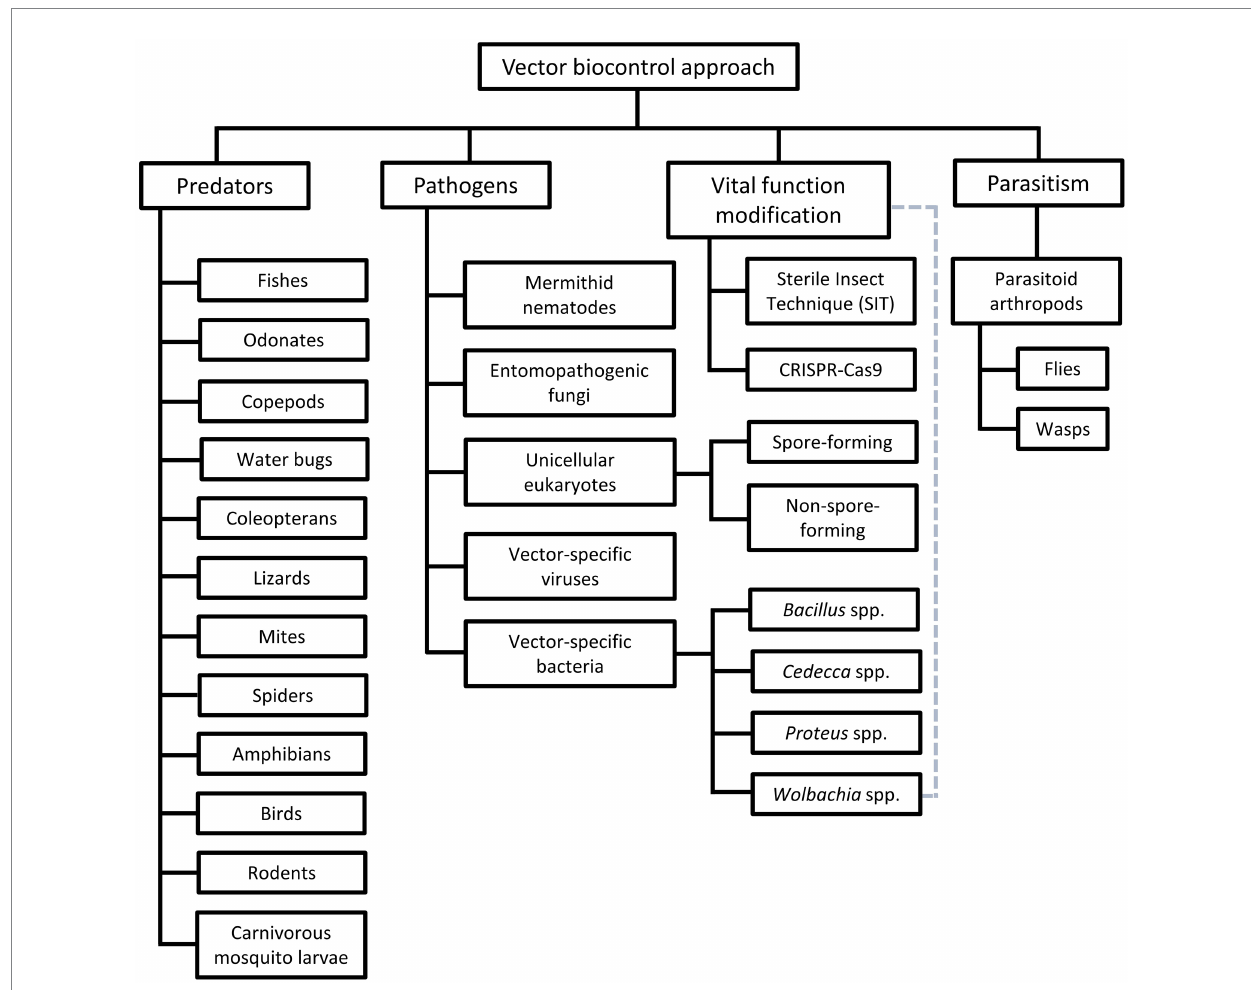
FIGURE 2 Different groups of vector biocontrol approach. Gray dotted lines reflect the characteristics of the Wolbachia method that combines the features of biocontrol approaches mediated by pathogens and vital function